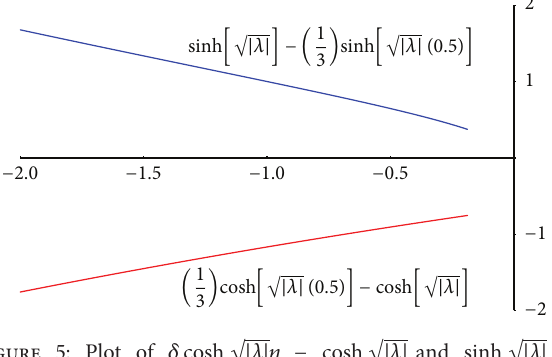
Figure 1: Plot of sin √𝜆 − 𝛿 sin √𝜆𝜂 and 𝛿 cos √𝜆𝜂 − cos √𝜆 .